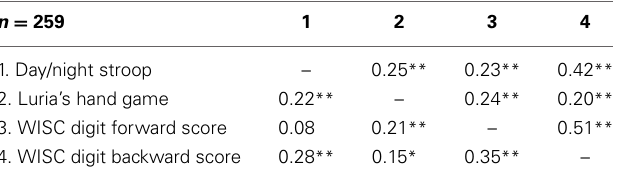
Table 1 | Correlations between scores on the inhibitory control tasks and working memory tasks.